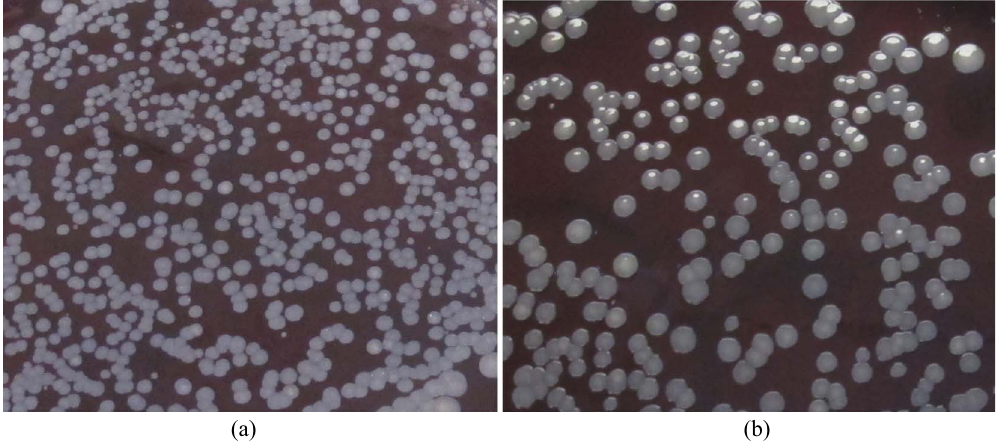
Figure 2. Staphylococcus aureus ; Culture plates (a) Control. (b) 120